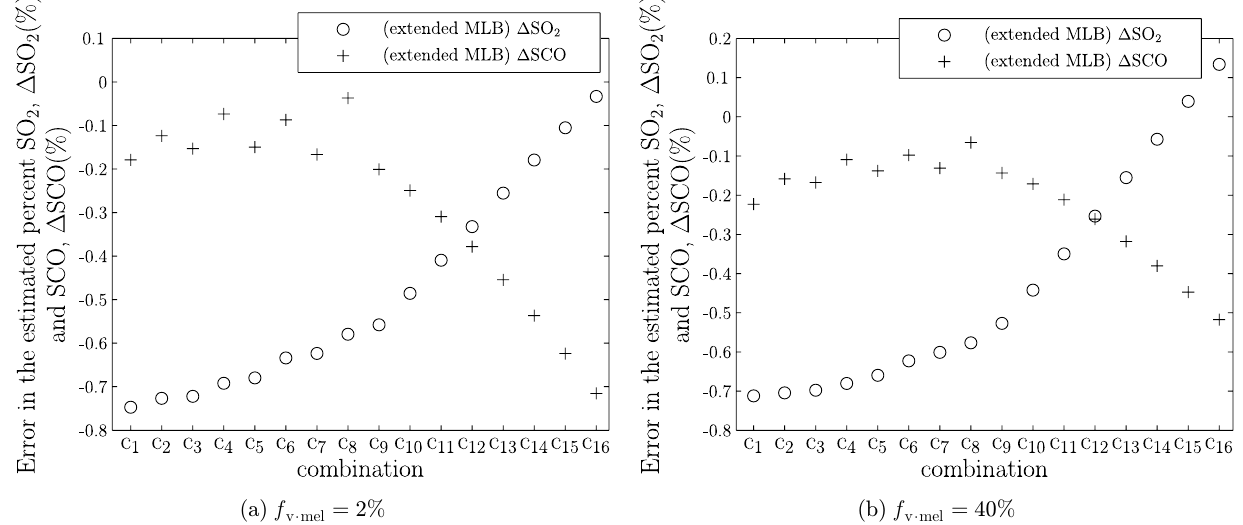
Fig. 3. Error in blood OxyHb saturation (cid:1)SO 2 (\o") and blood COHb saturation (cid:1)SCO (\+") estimated by extended MLB when volume fraction of melanosomes ( f v (cid:3) mel ) is (a) 2 % and (b) 40 % . The actual SO 2 and SCO used in Monte Carlo simulations are listed in Table